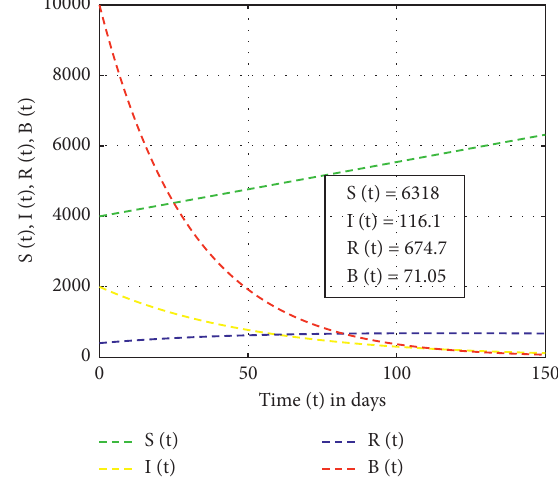
Figure 4: Simulation of the SIR-B model with strong control